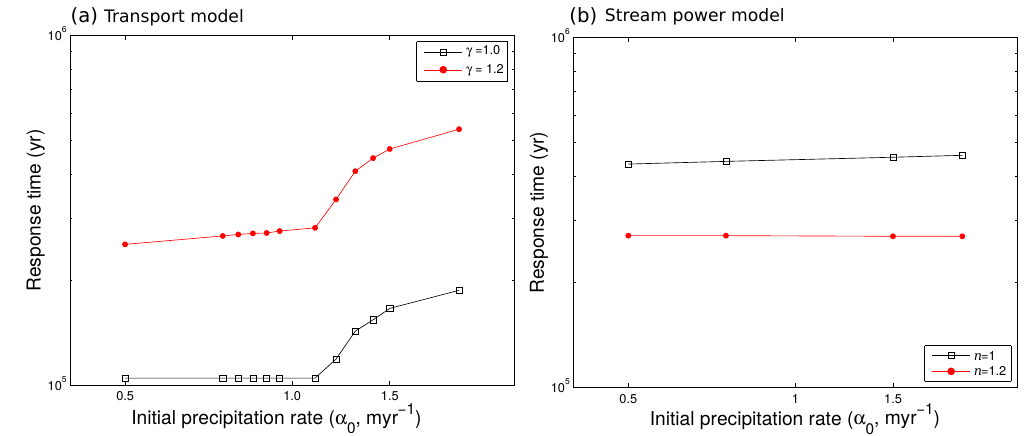
Figure 14. Log–log plots for the transport model and the stream power model in 1-D for a step change in precipitation rate; the initial precipitation rate, α 0 , varies from 0.5 to 1 . 5myr − 1 , and the final precipitation rate is fixed at α 1 = 1myr − 1 . (a) Results for the transport model. (b) Results for the stream power